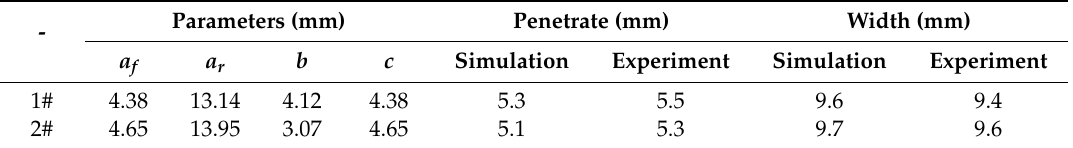
Table 4. Heat source model parameters and simulation results.